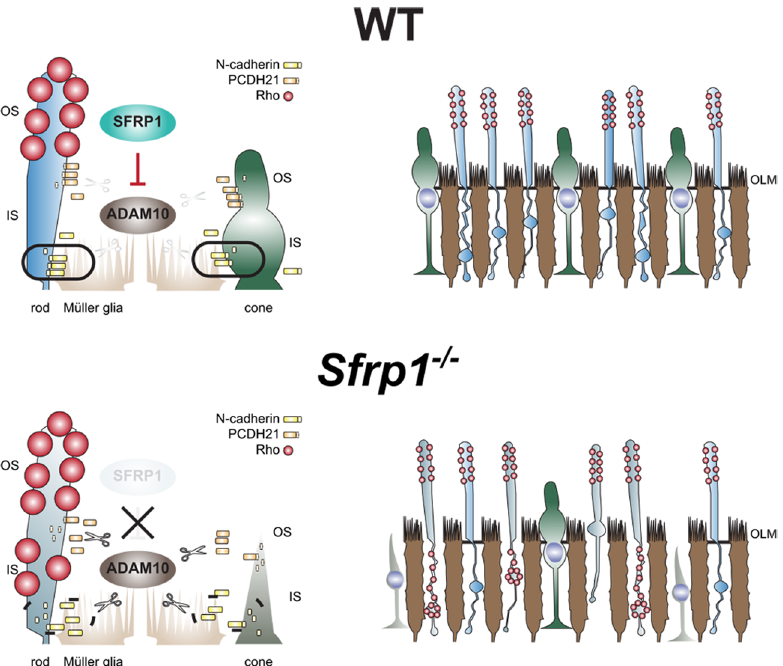
Figure 8. Proposed model for the defects observed in the Sfrp1 − / − mice. See the discussion for details. Abbreviations: IN: inner segment; OLM: outer limiting membrane; OS: outer segment. (EC author ‘s